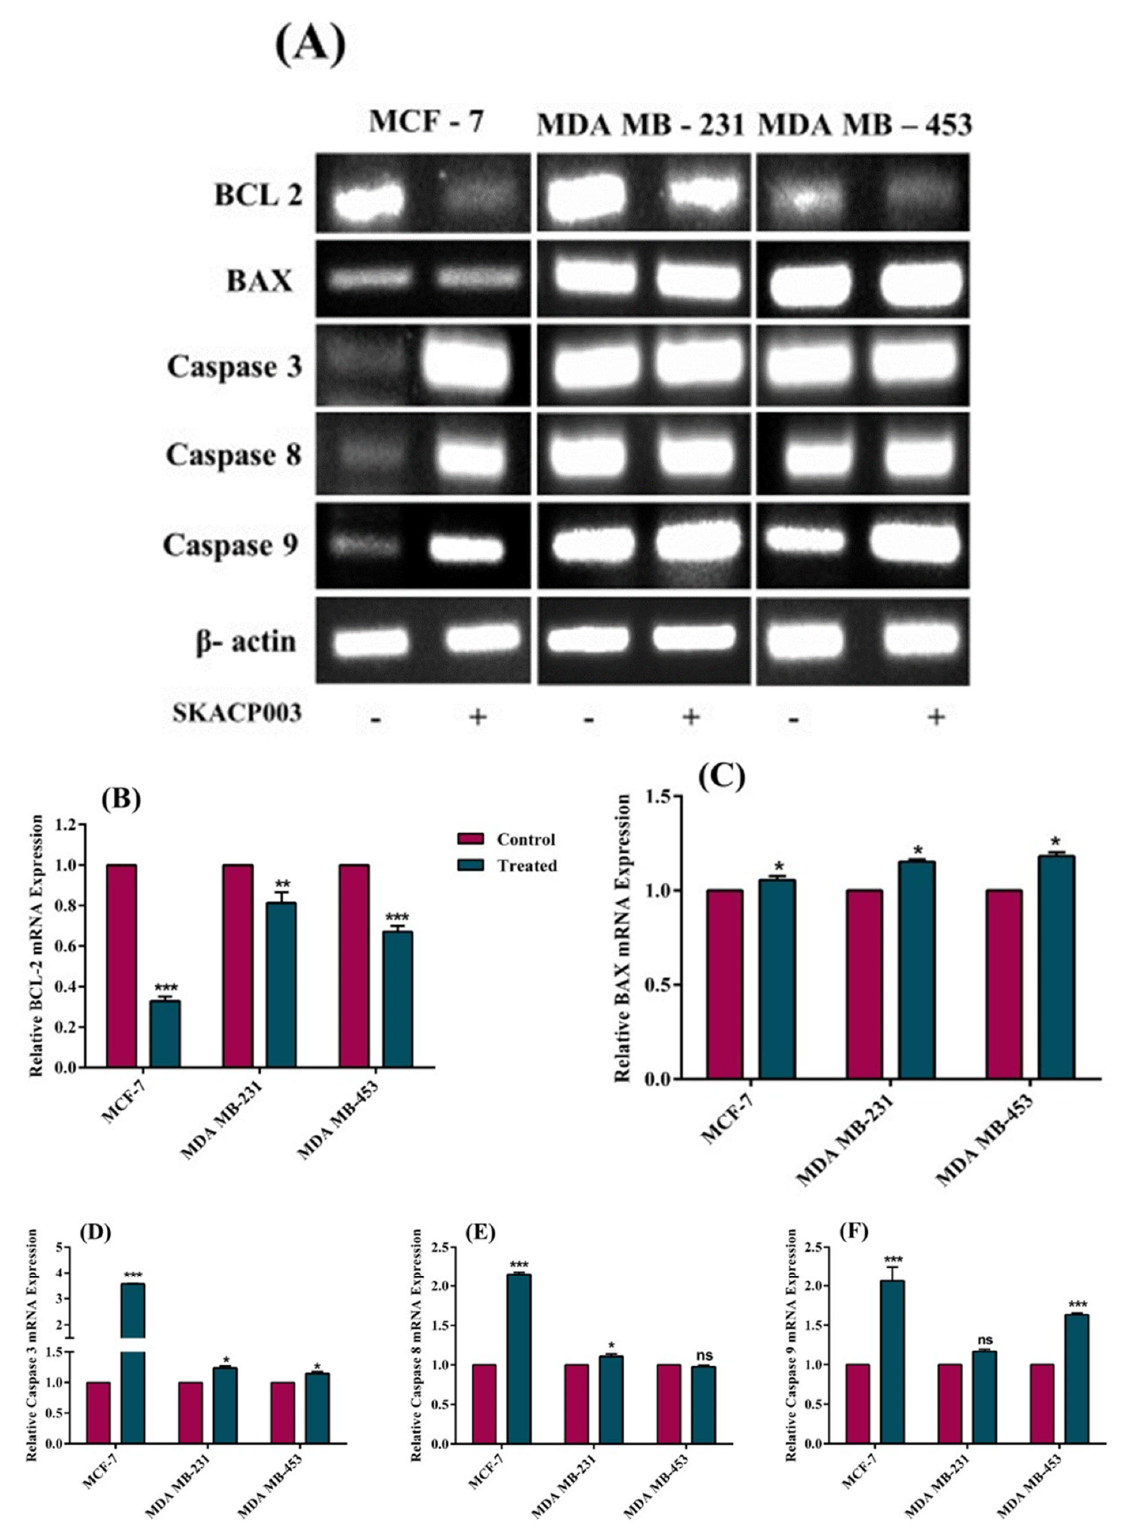
Figure 5. Effect of SKACP003 on the apoptotic pathway of the breast cancer cell lines. RT-PCR ( A ) was used to analyse the mRNA levels of ( B ) BCL-2, ( C ) BAX, ( D ) Cas-3, ( E ) Cas-8, and ( F ) Cas-9 from total RNA for the control and SKACP003-treated breast cancer cell lines of MCF-7, MDA-MB-231, and MDA-MB-453. * = statistical significance at p < 0.05; ** = statistical significance at p < 0.01; *** = statistical significance at p < 0.001; ns = not